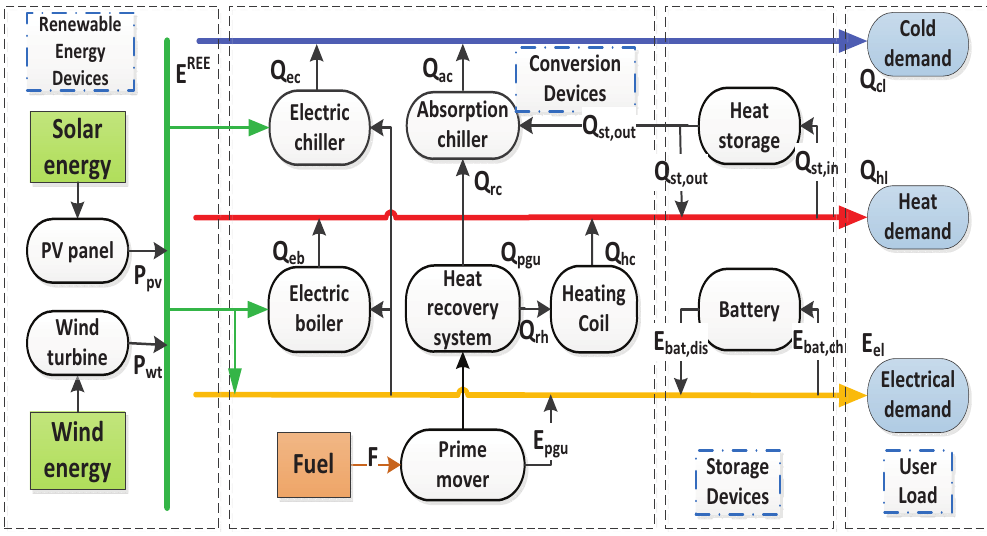
Figure 3. Illustration of the renewable energies integrated CCHP (RECCHP) system structure in isolated mode. PV: